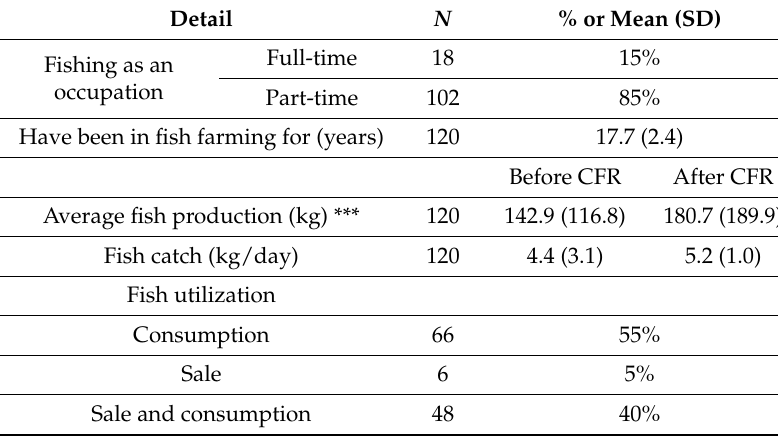
Table 3. Fish catch and fish